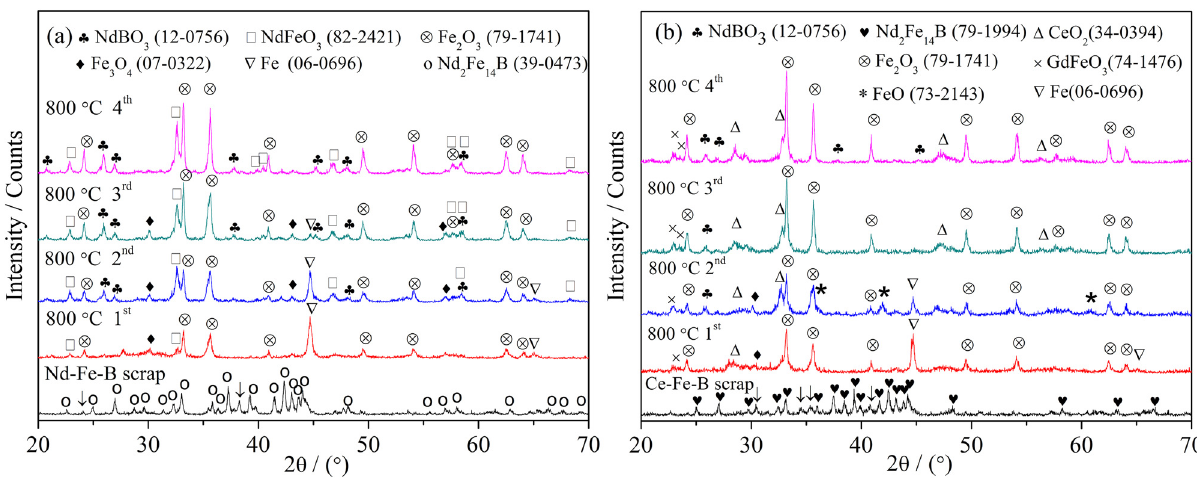
Figure 2: Phase evolution of the Nd – Fe – B and Ce – Fe – B magnet scrap powders with di ff erent roasting cycles at 800°C. ( a ) Nd – Fe – B scrap powder; ( b ) Ce – Fe – B scrap